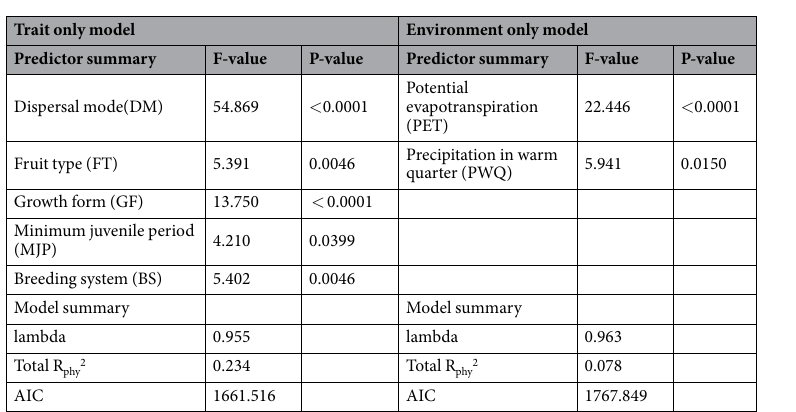
Table 3. Summary of the best phylogenetic model for seed mass as a function of trait predictors alone, and climate as predictors alone. n =